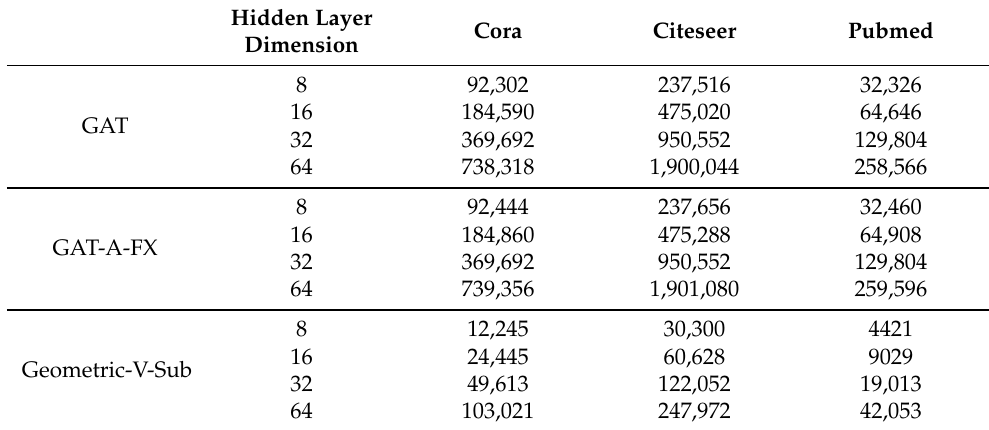
Table 3. Parameter comparison in transductive learning.